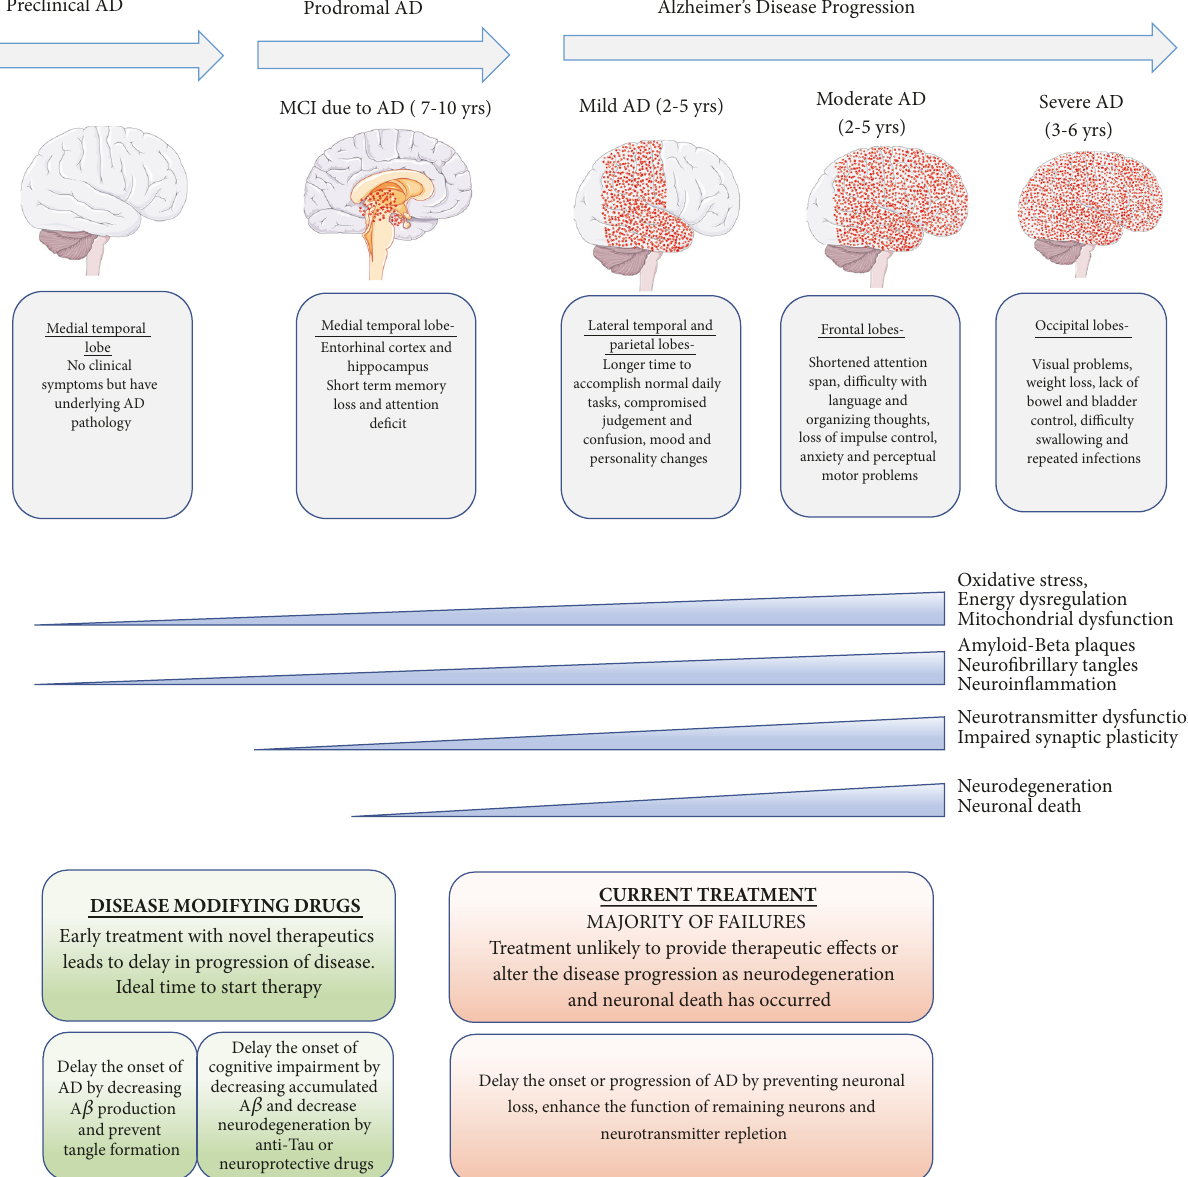
Figure 3: Description of progressive clinical stages and pathologies associated with Alzheimer’s disease (AD) for relevance in developing therapeutic strategies for mitigating progression of